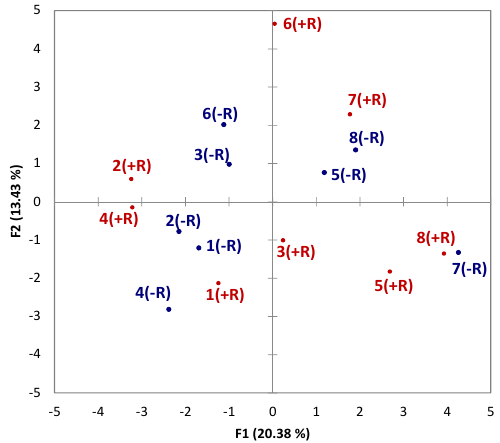
Figure 1. Multiple factor analysis of Napping ® results of Chardonnay wines analyzed +R ( red ) and − R ( blue ).